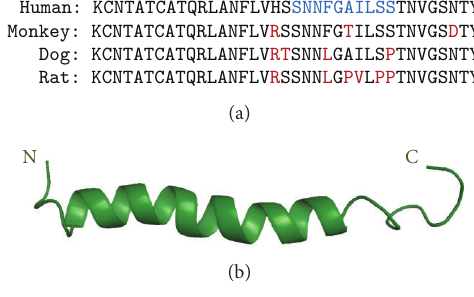
Figure 1: (a) Comparison of amino acid sequences of IAPP from differentspecies.Residuesthatdiffertothoseofhumanareindicated in red bold whereas the human 20–29 amyloidogenic segment is represented in bold blue. (b) Schematic ribbon representation of sodium dodecyl sulfate micelle-bound IAPP secondary structure (PDB code: